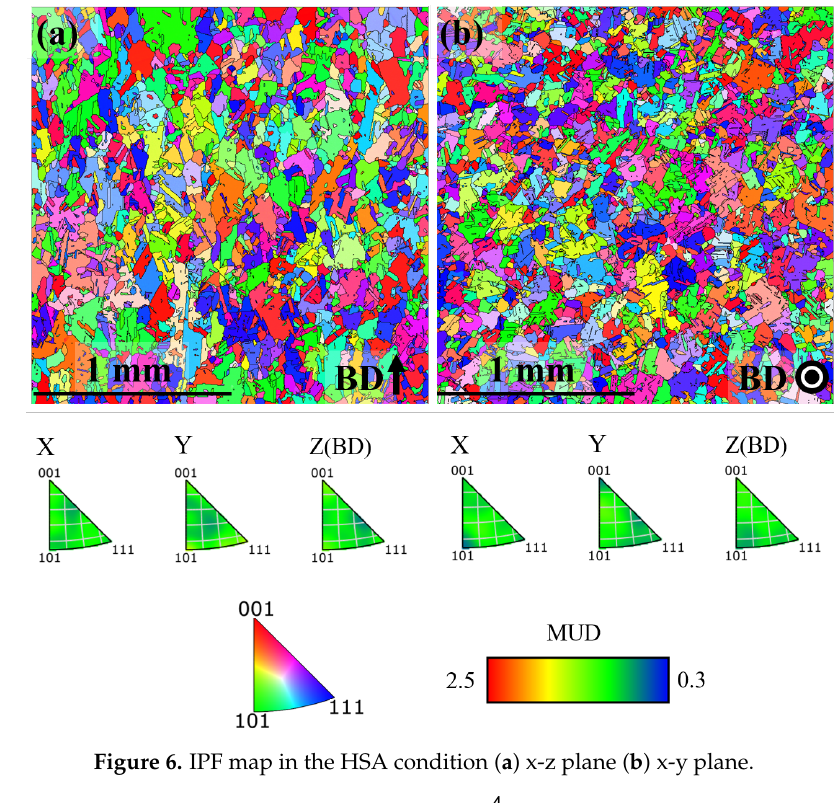
Figure 6. IPF map in the HSA condition ( a ) x-z plane ( b ) x-y plane.